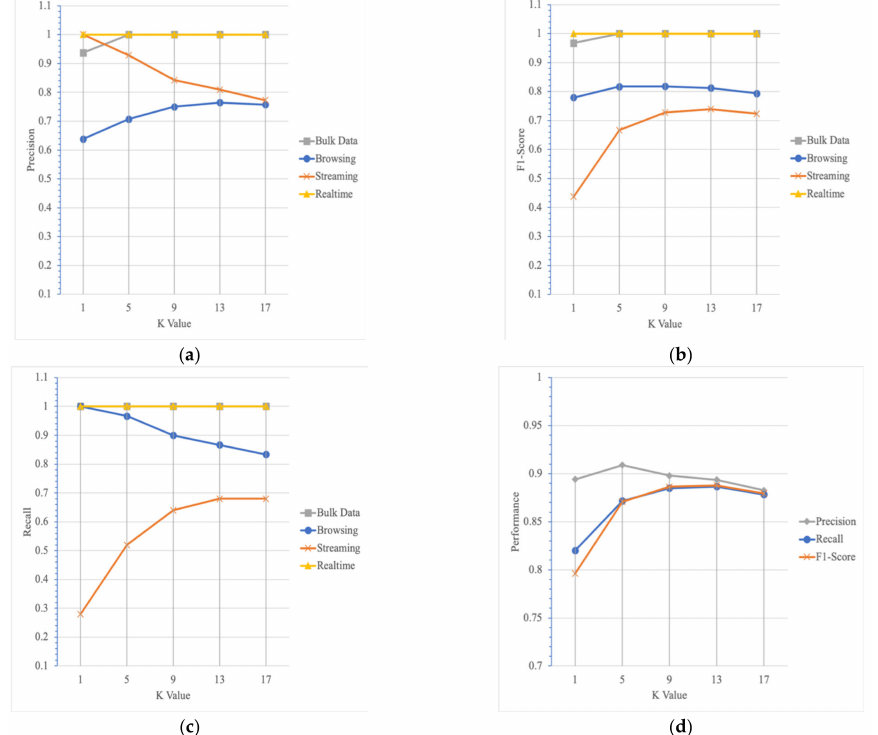
Figure 14. The results of majority voting after removing the first three packets ( a ) accuracy of each category, ( b ) recall rate of each category, ( c ) F1-Score of each category, and ( d ) Average of each category